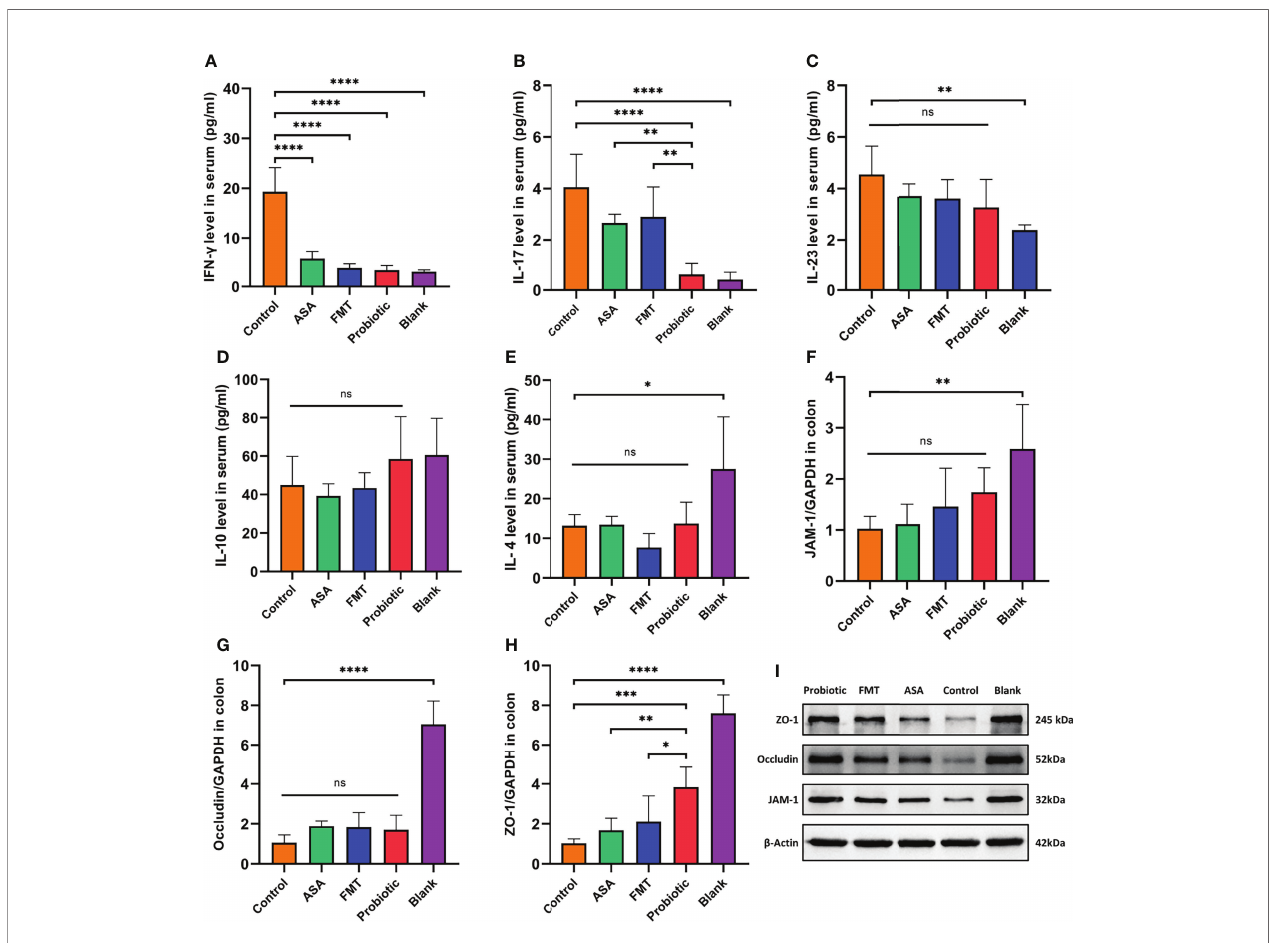
FIGURE 2 | The probiotic cocktail repaired the gut barrier and reduced in fl ammatory factors in DSS-induced colitis. (A – E) The level of serum in fl ammatory cytokines (pro-in fl ammatory IFN-gamma, IL-17, and IL-23; anti-in fl ammatory IL-10 and IL-4) in blank mice, and DSS-induced colitis mice treated with PBS, healthy mice donor FMT, 5-ASA, or the probiotic cocktail. (F – H) The mRNA expression of tight junction protein (JAM-1, Occludin, ZO-1) of colon tissues in each group. (I) The protein expression of tight junction protein (JAM-1, Occludin, ZO-1) of colon tissue in each group. One-way ANOVA test was utilized, and data were shown as mean ± SD. * p < 0.05; ** p < 0.01; *** p < 0.001; **** p < 0.0001; ns, no signi fi cant difference. DSS, dextran sodium sulfate; PBS, phosphate buffered saline; FMT, fecal microbiota transplantation; 5-ASA, 5-aminosalicylic